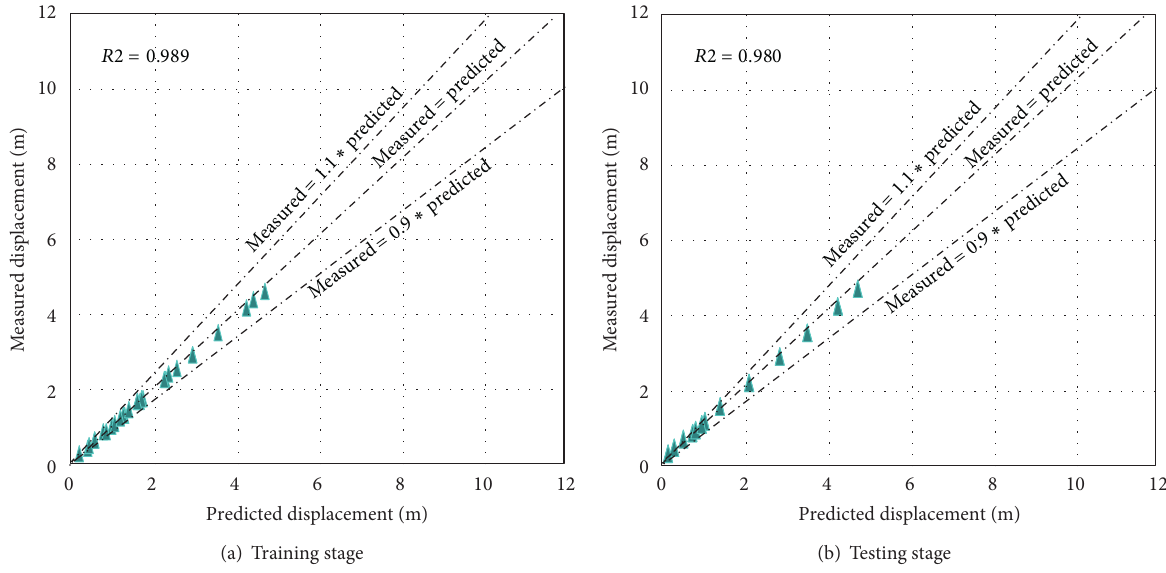
Figure 36: Comparison between NEFLAS and measured lateral spread, Imperial Valley, USA. (a) Training stage and (b) testing stage.